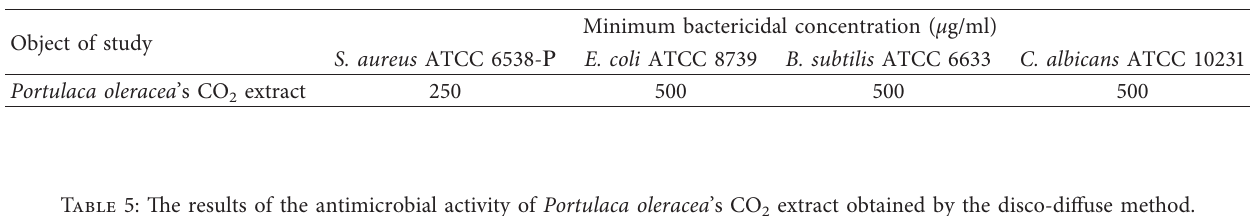
2 extract obtained by the serial dilution method.